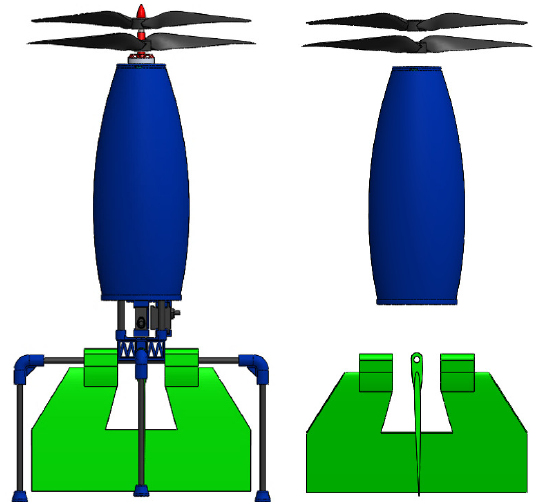
Figure 4. MCR UAV v3.0 simplified model for CFD